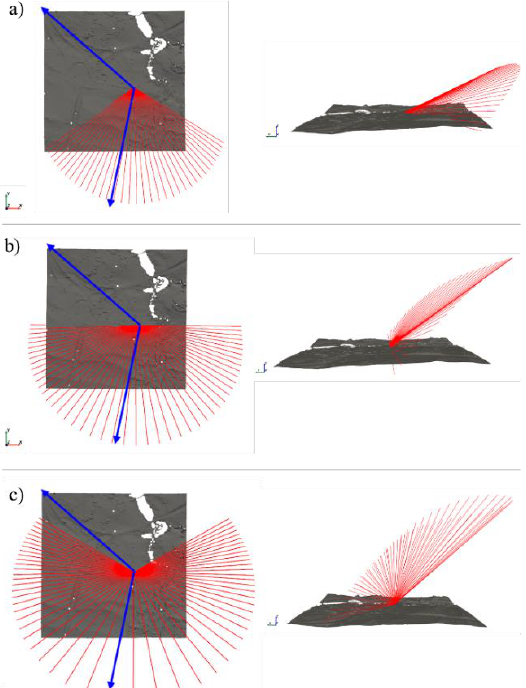
Figure 8. Sun ray intersections with obstacles in the roundabout vector 7 during daylight. Sun rays are represented by red lines and intersections are indicated with cyan points: a) winter solstice, b) equinoxes, c) summer